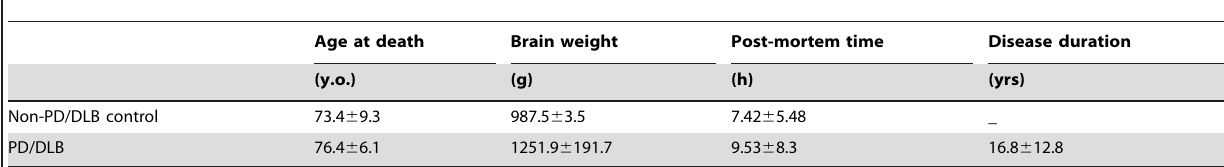
Table 2. Statistical representation of the clinical information on the postmortem brains.